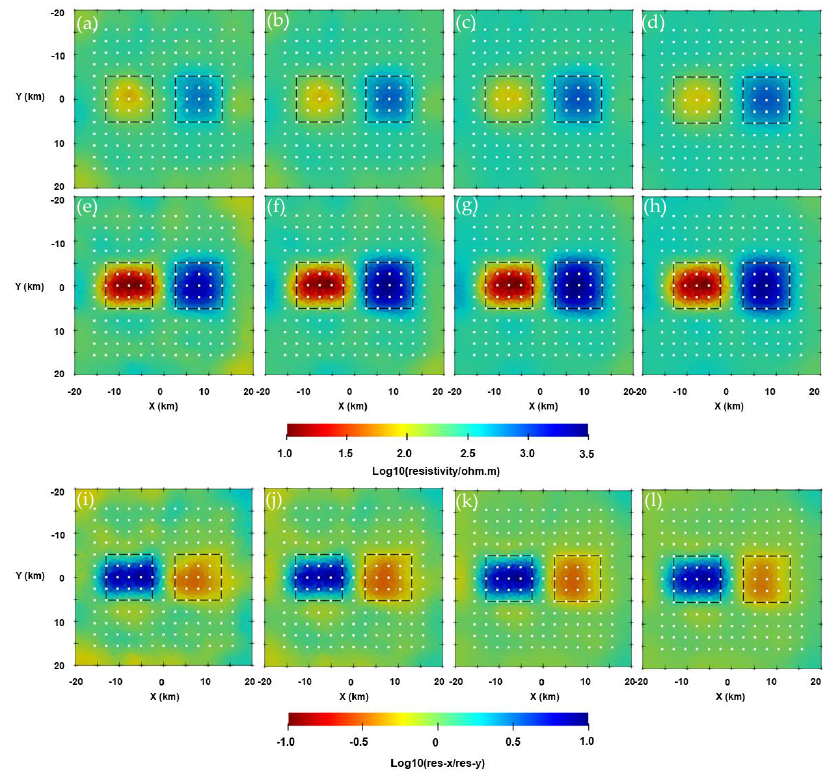
Minerals 2022 , 12 , x FOR PEER REVIEW 23 of 26 Figure A4. Anisotropic inversion results at z = 6 km for different 𝑞 𝑖 , and 𝑐 = 1 . Panels ( a ) – ( d ) show Figure A4. Anisotropic inversion results at z = 6 km for different q i , and c = 1. Panels ( a )–( d ) show the inverted resistivity in the principal X direction for 𝑞 𝑖 = 0.05,0.1,0.4,0.8 . Panels ( e ) – ( h ) show the the inverted resistivity in the principal X direction for q i = 0.05, 0.1, 0.4, 0.8. Panels ( e )–( h ) show the inverted resistivity in principal Y direction for 𝑞 𝑖 = 0.05,0.1, 0.4,0.8 . Panels ( i ) – ( l ) show the inverted inverted resistivity in principal Y direction for q i = 0.05, 0.1, 0.4, 0.8. Panels ( i )–( l ) show the inverted anisotropic coefficient for 𝑞 𝑖 = 0.05,0.1,0.4,0.8 . anisotropic coefficient for q i = 0.05, 0.1, 0.4, 0.8.